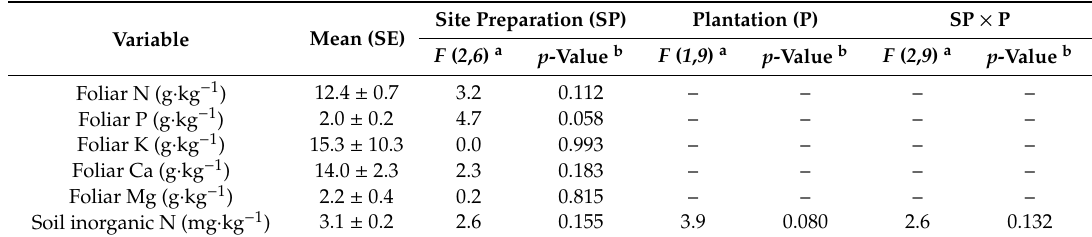
Table 1. Synthesis of the linear mixed model results for hybrid poplar foliar nutrition and soil inorganic N, as measured four growing seasons after